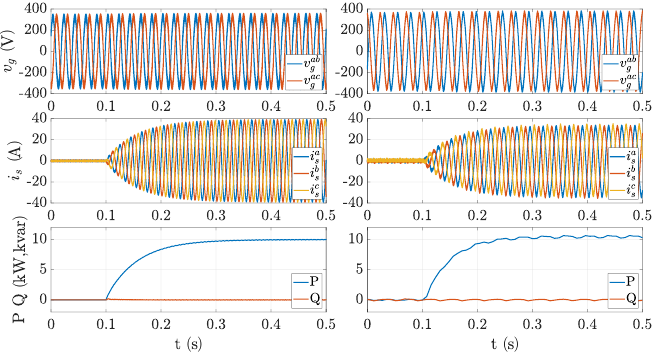
Figure 15. Simulation ( left ) and experimental ( right ) results, showing AC grid voltages, currents and powers for a step in P from 0 to 10 kW.